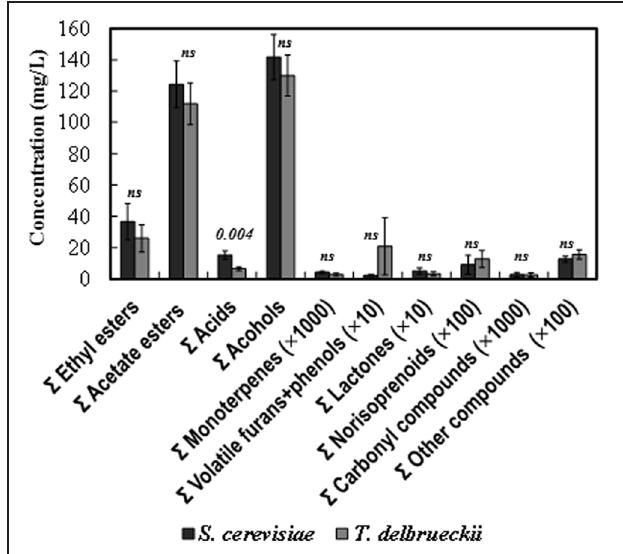
FIGURE 4 | Aroma compound composition of the S. cerevisiae -dominated or T. delbrueckii -dominated wines. The amounts for the similar chemical compounds were pooled as summatory. The data are the mean ± standard error of 23 independent vinifications made in duplicate, 11 inoculated with S. cerevisiae and 12 with T. delbrueckii . Statistically significant difference (p) is stated in the top of the bars. ns , no significant